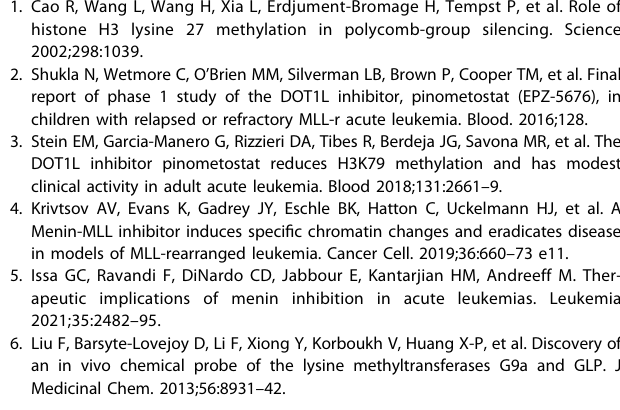
Fig. 6 G9a suppression triggers apoptosis and autophagy in T-ALL. A TEM micrographs illustrating the morphology of untreated (DMSO) T-ALL cells and the effects of BIX01294, UNC0638, and UNC0642. Black rectangles (upper) inscribe areas shown at higher magni fi cation (lower) to illustrate the phases of autophagosome (Ap) formation with G9a inhibitions. Scale bars: upper panels DMSO 1 µm, G9a inhibitors 2 µm; lower panels DMSO 0.5 µm, G9a inhibitors 1 µm. B Representative images of May – Grunwald – Giemsa stained cytospin preparations of T-ALL (PF382 and SUPT1) cultured in vehicle (DMSO) or BIX01294, UNC0638, or UNC0642 for 48 h. Extensive cytoplasmic vacuolization is apparent following exposure to G9a inhibitors. Images were captured with a Leica ICC50W optical microscope (100X). Scale bars: 13 µm. C Western blot showing expression of LC3B-II in PF382 and SUPT1 cells treated at the indicated concentrations of G9a inhibitors for 48 h. HSP90 was used as a loading control. D LysoTracker ® Red DND-99 staining of T-ALL cells labeled treated with BIX01294, UNC0638, and UNC0642 treatment for 48 h. Scale bars: 100 µm. E Western blot showing expression of G9a, 2 days post sgRNA selection. Protein lysates were blotted with a G9a, LC3B-II antibody, HSP90 was used as loading control. NT non-targeting, #2 = sgRNA #2 directed against EHMT2 . F LysoTracker ® Red DND-99 staining of T-ALL cells 2 days post sgRNA selection. Scale bar: 100 μ m. NT non-targeting, #2 = sgRNA #2 directed against EHMT2 . Scale bars: 100 µm. G LysoTracker ® Red DND-99 staining of T-ALL cells 2 days post selection for shRNA targeting SESN2 selection. Scale bar: 200 μ m. H Western blot showing expression of sestrin2 in wild type or cDNA- SESN2 -orf PF382 and SUPT1 cells treated at the indicated concentrations of G9a inhibitors for 48 h. HSP90 was used as a loading control. I LysoTracker ® Red DND-99 staining in wild type or cDNA- SESN2 -orf PF382 and SUPT1 cells treated at the indicated concentrations of G9a inhibitors for 48 h. Scale bars: 200 µm (left). Histograms show the mean and standard deviation of RFP per fi eld ( n = 10) relative to the vehicle control. Statistical signi fi cance among groups (* P < 0.05, *** P < 0.001, **** P < 0.0001) was determined by a non-parametric t -test (Mann –